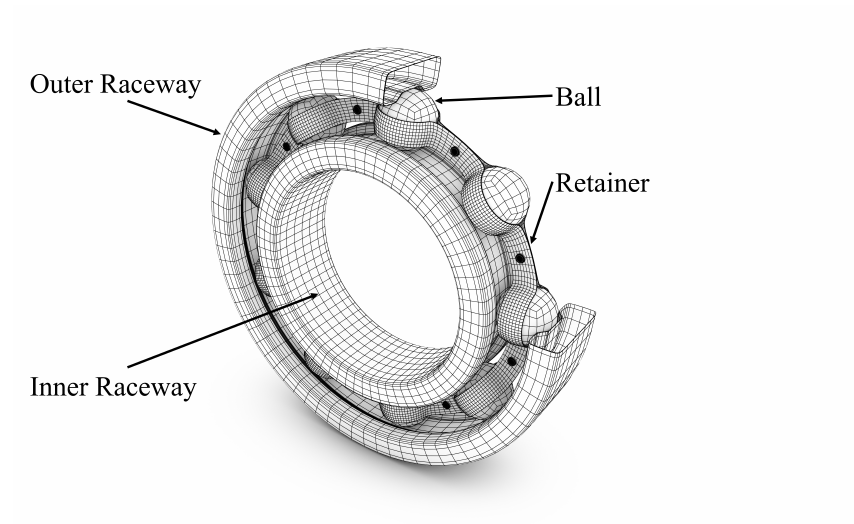
Figure 7. Components of rolling bearing.